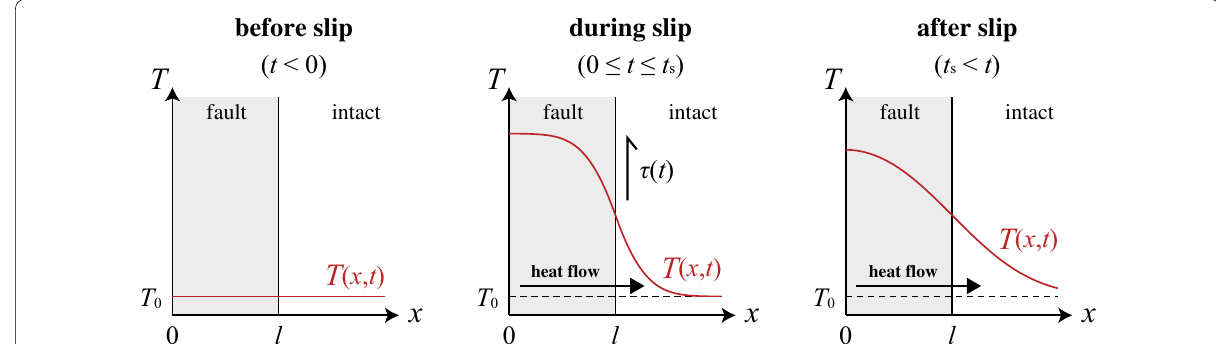
t t l s ), a fault zone of width 2 ≤ ≤